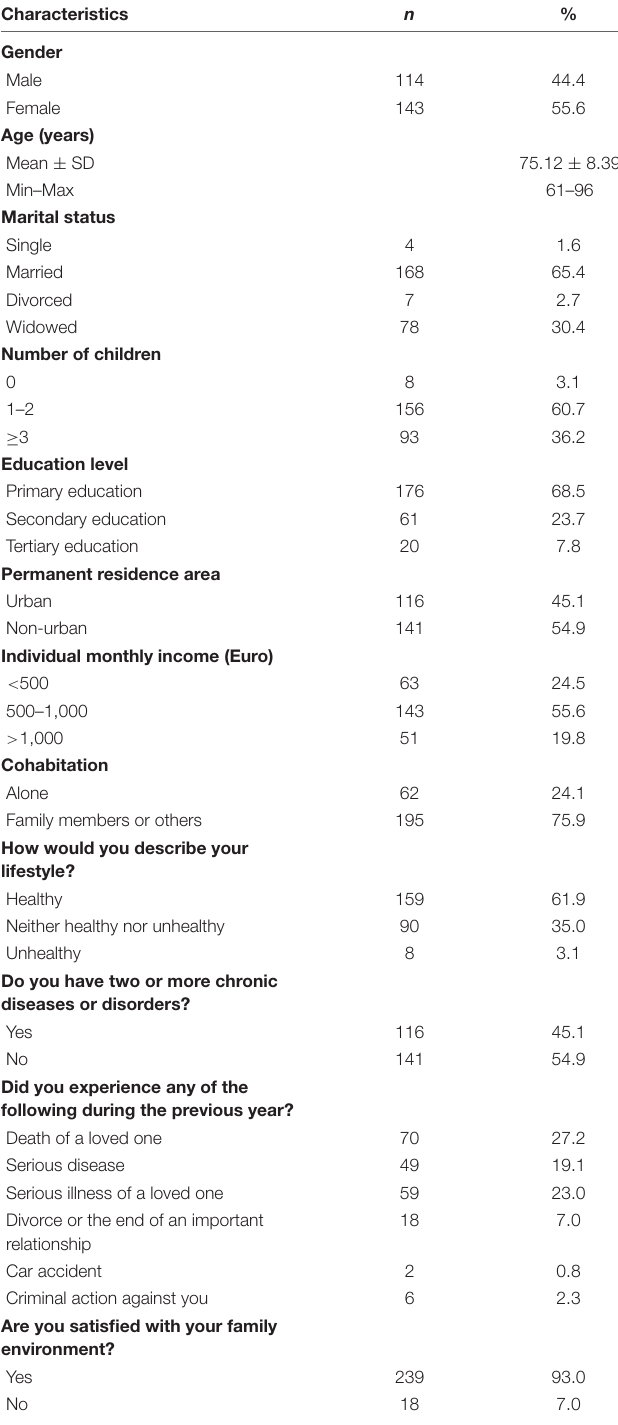
TABLE 1 | Individual features of the older adults ( n =